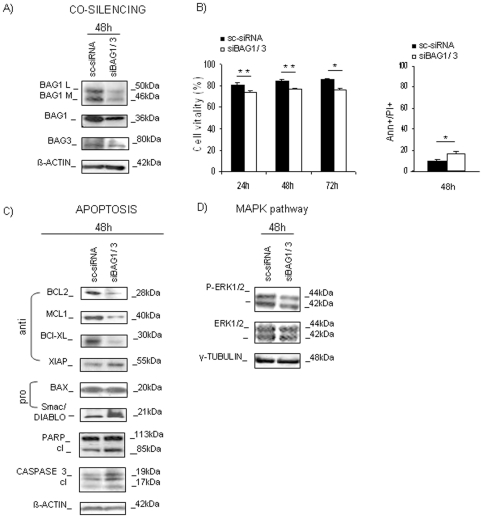
BAG1/3 co-silencing (BCS) in HL60 cells.A) WB after co-silencing is shown at 48 h after transfection. B) Cell vitality was calculated by trypan-blue exclusion assay after BAG1/3 co-silencing (BCS). The first graph shows the percent of living cells 24 h, 48 h, and 72 h after BCS (white bars), or silencing with control sc-siRNA (black bars); the second graph shows the percent of apoptotic (Ann+/PI+) cells 48 h after transfection. Data are presented as mean ± S.E.M. of three independent measurements (n = 3; *p<0.05, **p<0.01). C) The expression of pro- and anti-apoptotic proteins was validated by WB 48 h post-transfection. Additionally, expression of apoptotic hallmarks, CASPASE-3 and PARP, and their cleavage (cl) was examined. D) WB analysis for the expression of MAPK pathway-related protein ERK1/2 after transfection with siBAG1/3 or sc-siRNA. β-ACTIN, and γ-TUBULIN are shown as total protein loading controls.